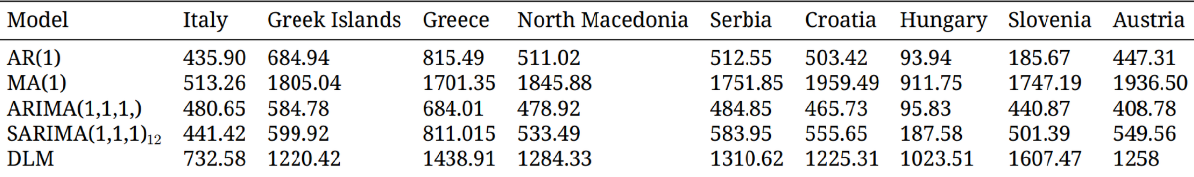
Figure 20. Average RMSE on one day ahead dynamic forecasts for daily arrivals with the various forecasting methods.